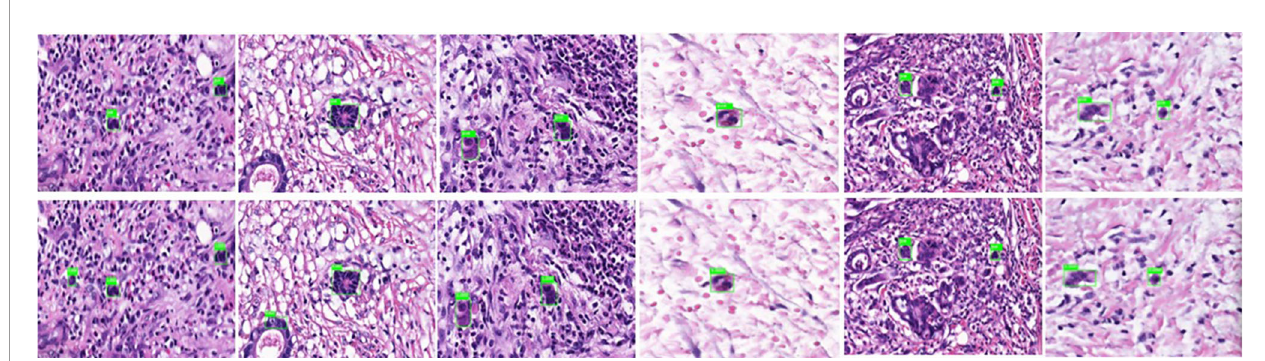
FIGURE 3 | Annotated tumor budding by computer and pathologists in test group. The upper panels show labeling by the pathologists, and the lower panels show labeling by